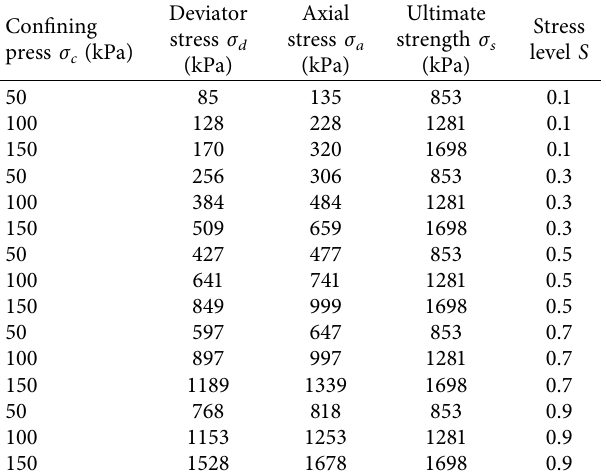
Table 4: Testing